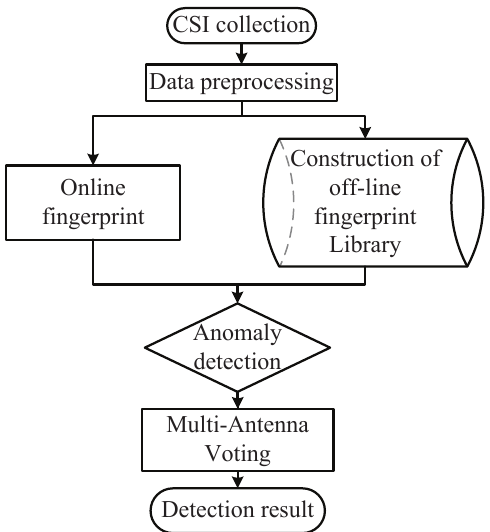
Figure 4. Flow chart of the proposed FDF-PIHD (Frequency Domain Fingerprint-based Passive Indoor Human Detection)